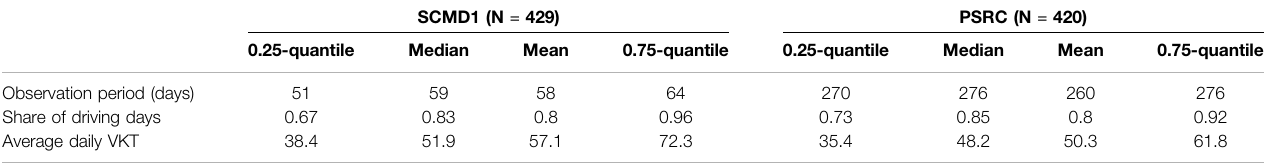
TABLE 1 | Summary statistics per vehicle in the two datasets the Swedish Car Movement Data (SCMD)and Puget Sound Research Council Data